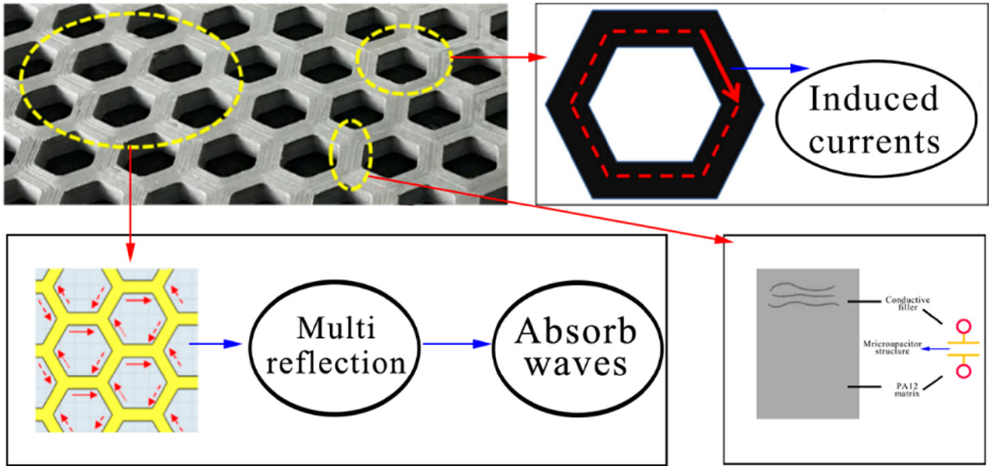
Figure 14. The absorbing principle of the honeycomb absorber.